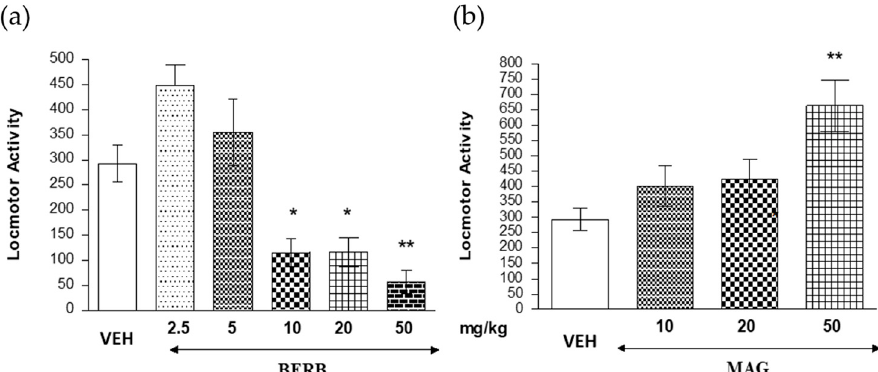
Figure 4. Effects of berberine (BERB) ( a ) and magnoflorine (MAG) ( b ) on the locomotor activity. The data are shown as the means ± standard error of the mean (SEM), photocell beam breaks of mice measured immediately after injection for 60 min; n = 9; * p < 0.05; ** p < 0.01 vs. vehicle (VEH)-treated control group; Tukey’s test.